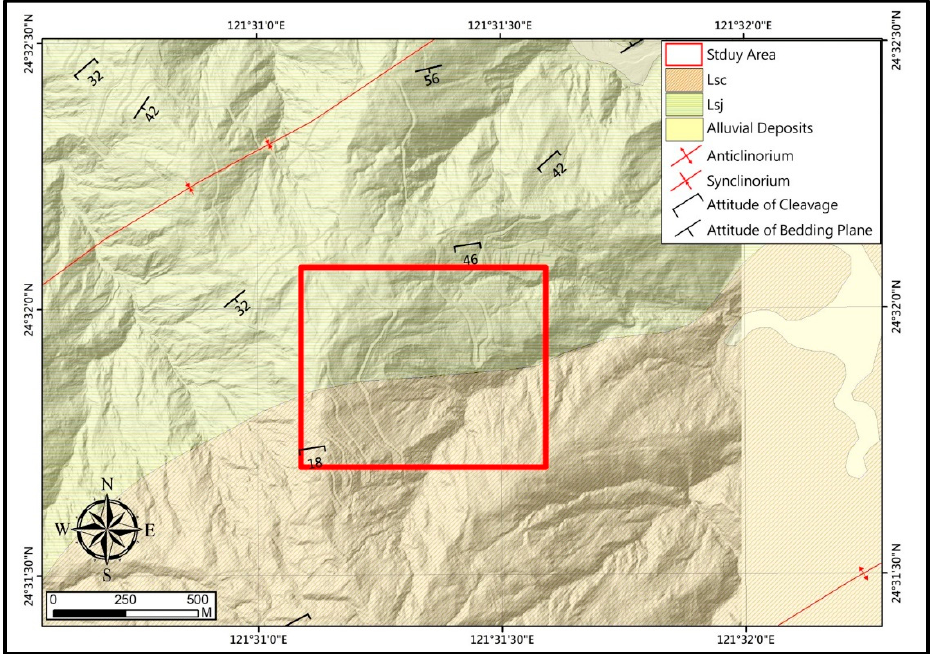
Figure 3. Geological map on the shaded relief of the study area, modified from 1:50,000 Geological Map, Sanshin Plate by Central Geological Survey, 1995 [19]. The Lsc indicates Lushan formation Chingshuihu Member, and the Lsj indicates Lushan Formation Jentse Member (WGS 84 coordi- nates).